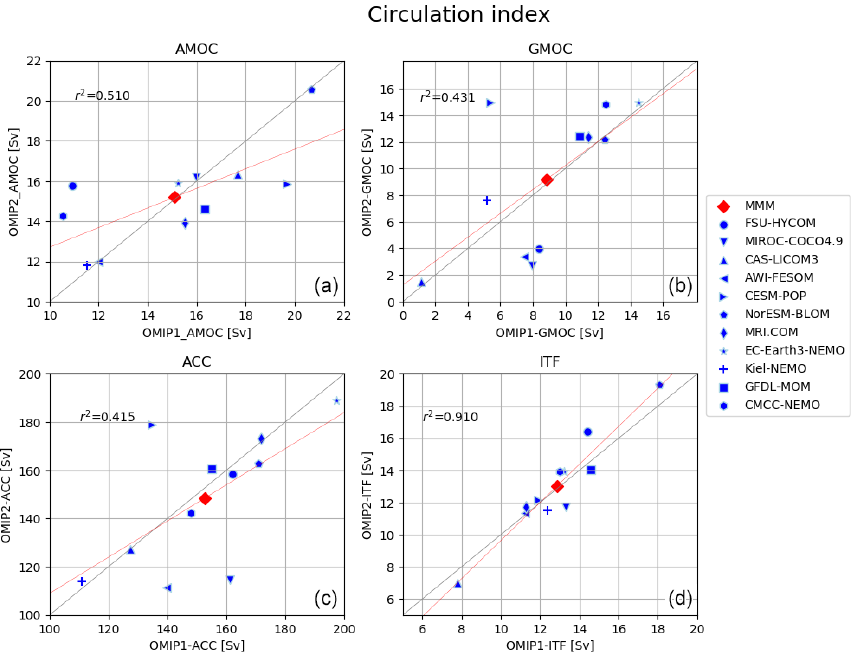
Figure 28. Same as Fig. 27 but for the 30-year mean (1980–2009) AMOC (a) , GMOC minimum in 2000m–bottom depths at 30 ◦ S (b) , Antarctic Circumpolar Current (ACC) (c) , and Indonesian Throughflow (ITF) (d) from OMIP-1 (abscissa) and OMIP-2 (ordinate). See Table D2 for specific